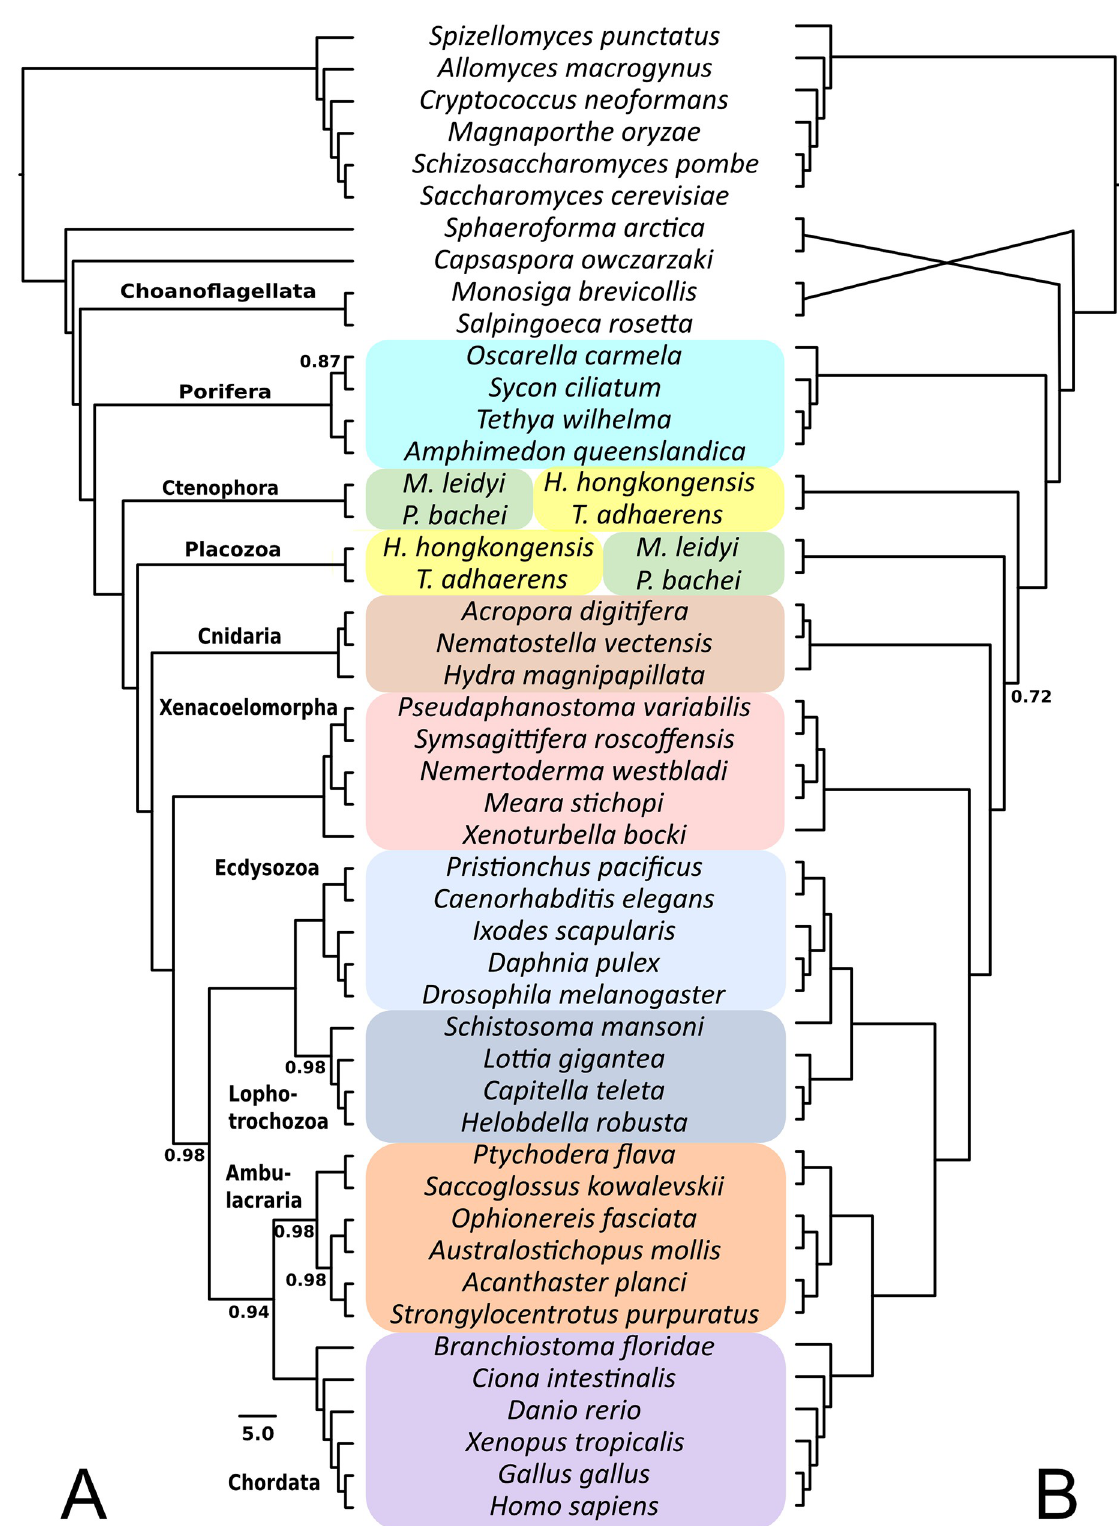
Fig 3. Reconstruction of animal phylogeny with 47 species (Opi taxon sampling) based on gene content datasets constructed with the default methods settings of I-value 1.5 and E-value 1e-3. Posterior probabilities lower than 0.99 are indicated. Note differences in branching order of closest outgroups, Ctenophora and Placozoa, as well as Schistosoma mansoni (Platyhelminthes). https://doi.org/10.1371/journal.pone.0282444.g003 PLOS ONE | https://doi.org/10.1371/journal.pone.0282444 March 23,